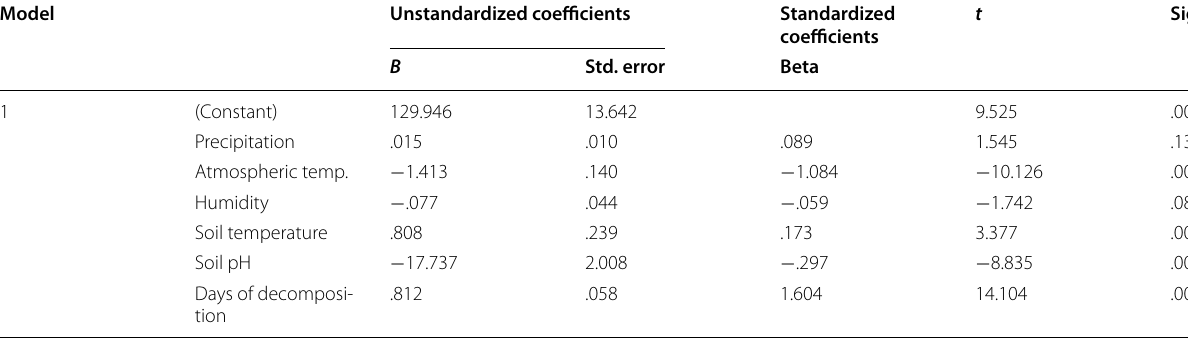
The regression equation is as